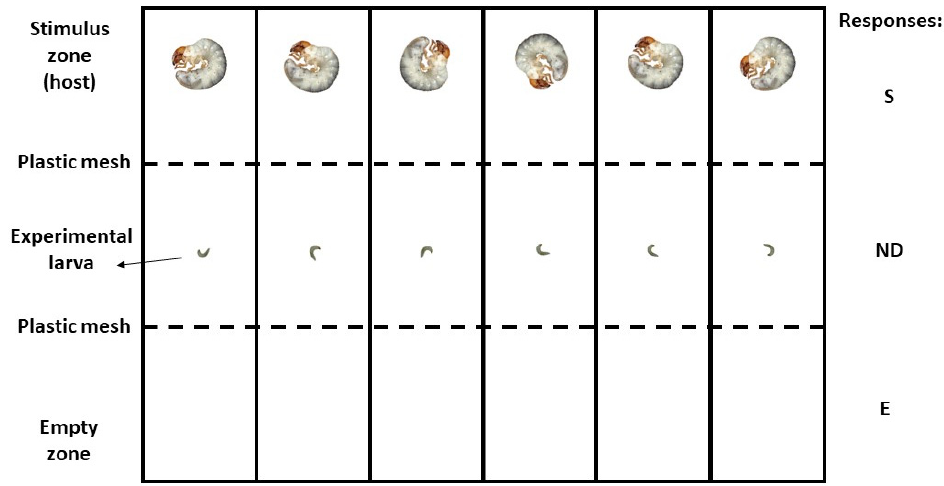
Figure 3. Diagram of the static air two-way olfactometer to measure the parasitoid host orientation to scarab beetle larva in dual choice tests. The device has six individual arenas. Responses: S: choice for the stimulus; E: choice for the empty zone or control; ND: no-decision. Each host zone was delimited by a plastic mesh that prevented hosts from leaving the zone.